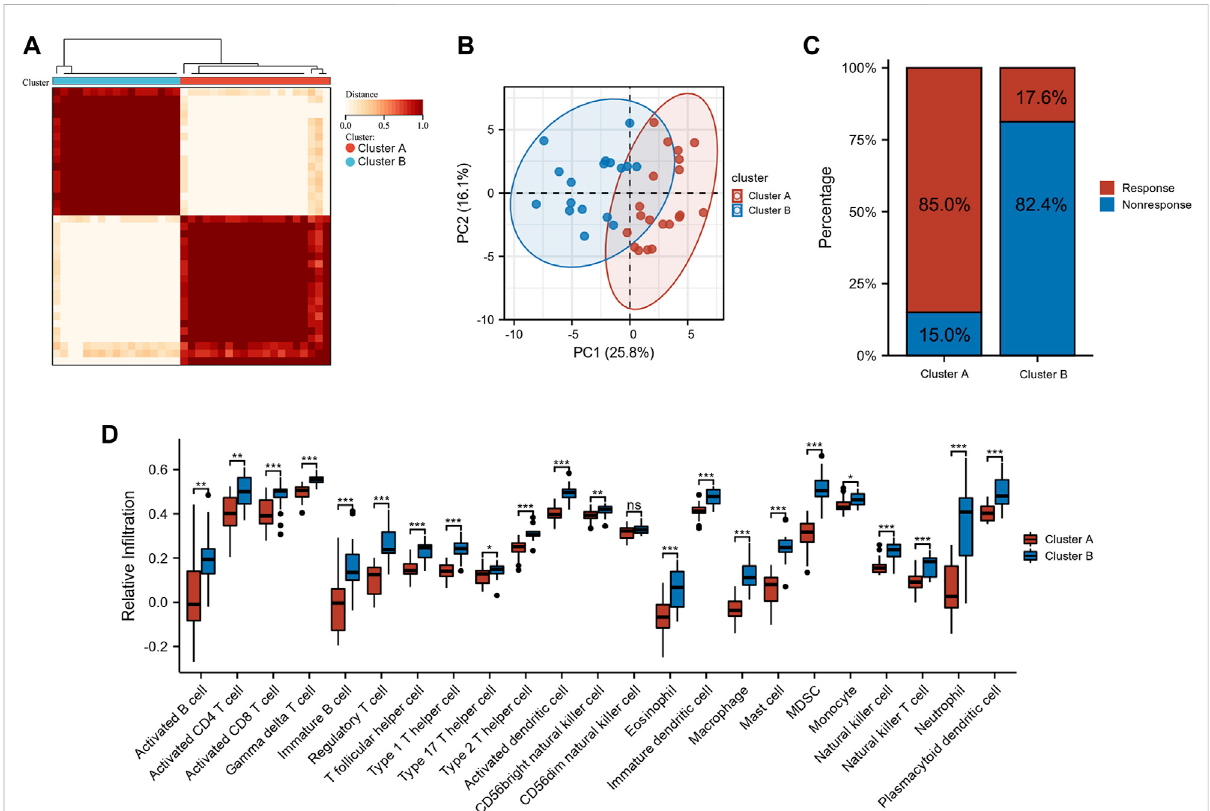
Identi fi cation of subtypes in CD. (A) Consensus clustering matrices of sialylation-related DEGs (k = 2). (B) PCA for the expression of sialylation- related DEGs to distinguish two subtypes. (C) Stacked bar plot of percentage of response and non-response patients in two subtypes (D) In fi